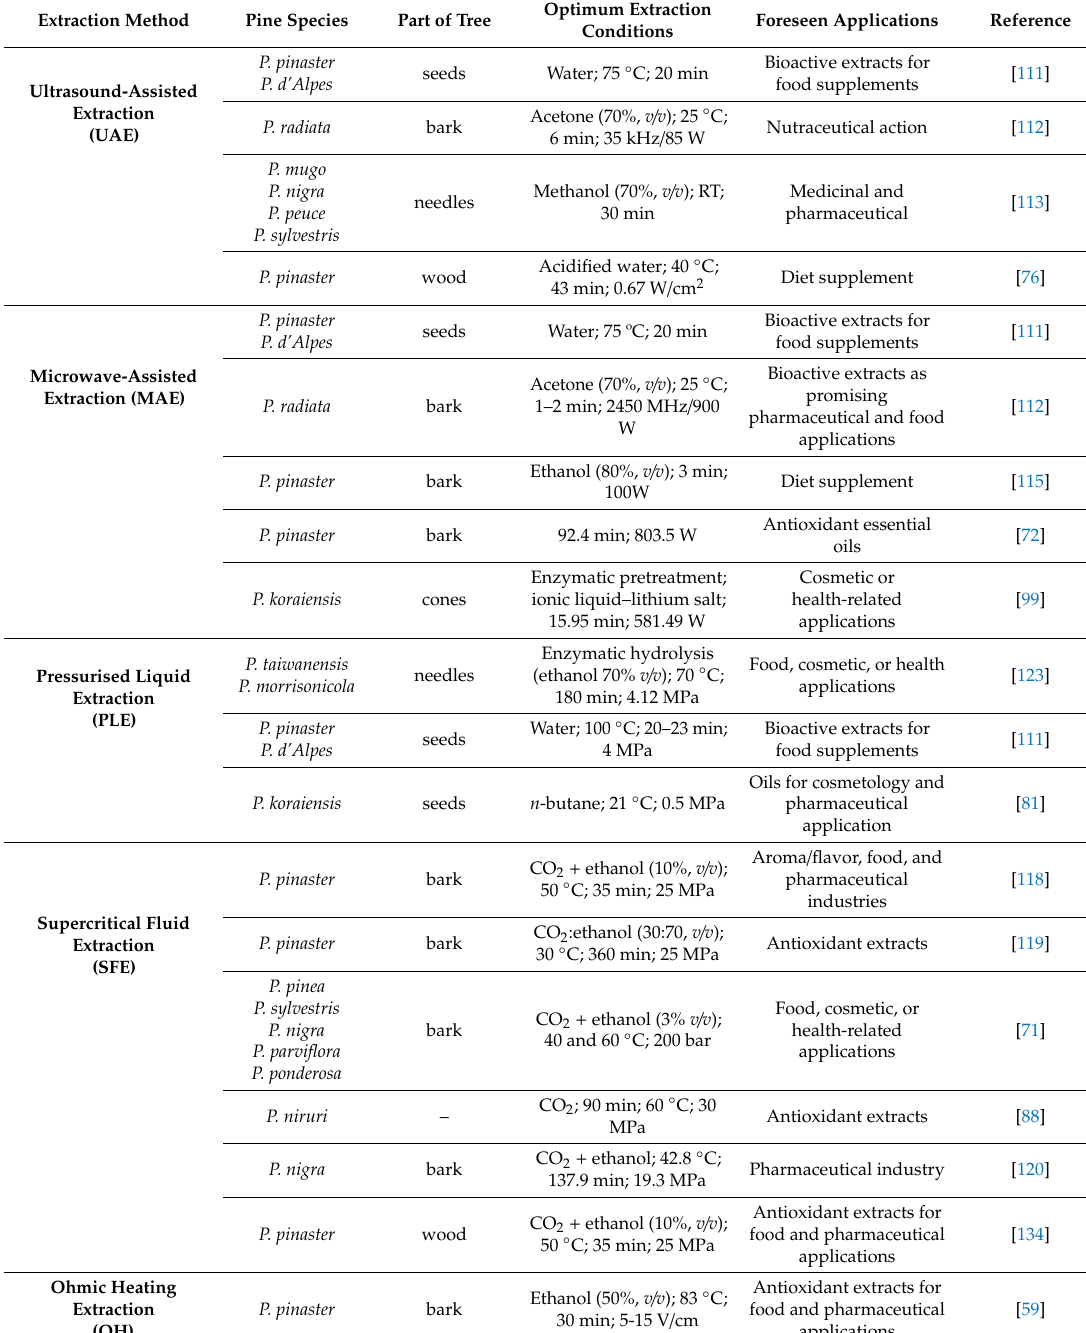
Table 2. Green technologies for phenolic compounds recovery from pine by-products and possible